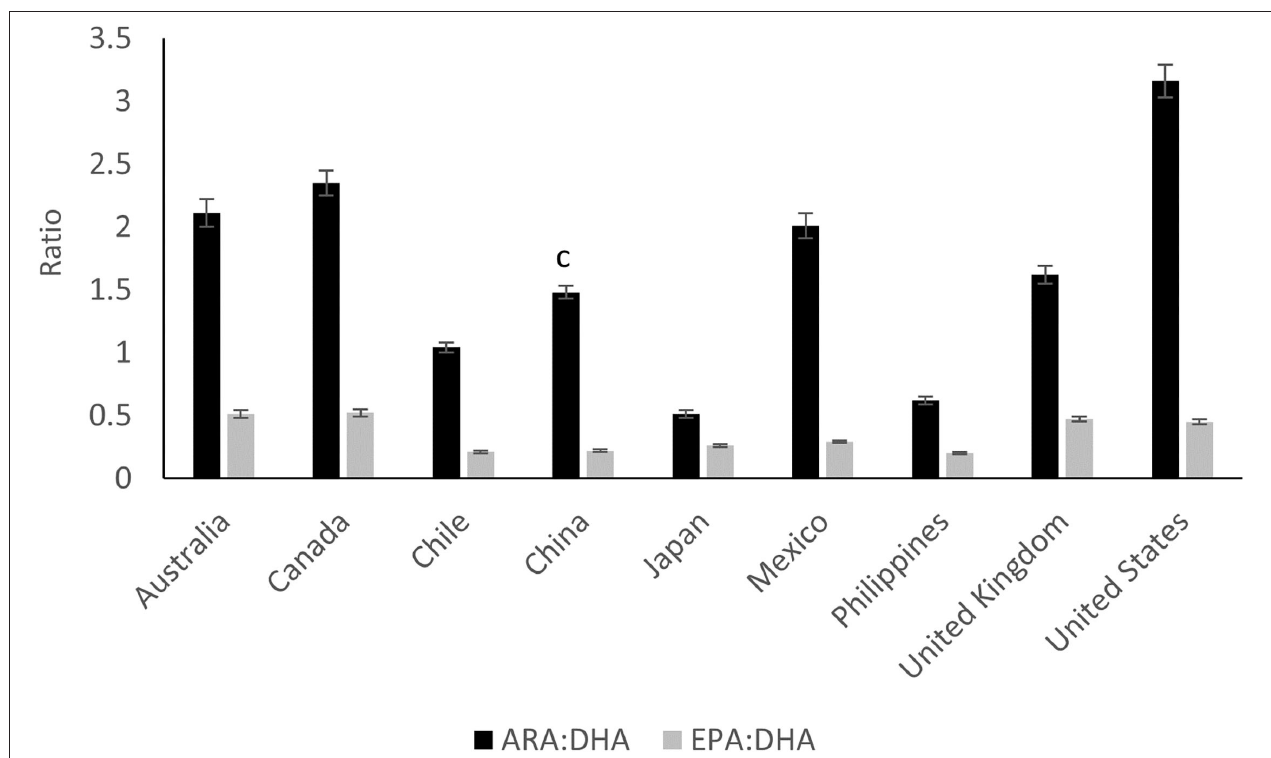
FIGURE 4 | The ratio of arachidonic acid to docosahexaenoic acid (ARA:DHA) and the ratio of eicosapentaenoic acid to docosahexaenoic acid (EPA:DHA) in mature human milk from nine different countries. Data extracted from Yuhas et al. ( 44). Means with different superscripts are statically different ( P < 0.05), n = 44–54, per